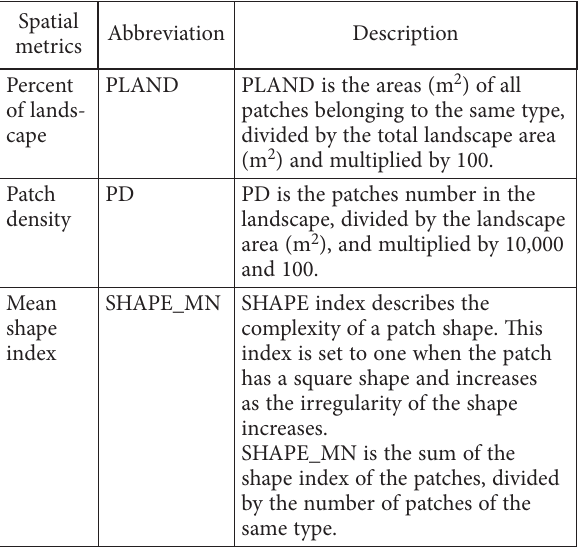
Table 2. Description of the spatial metrics used in this study. Spatial